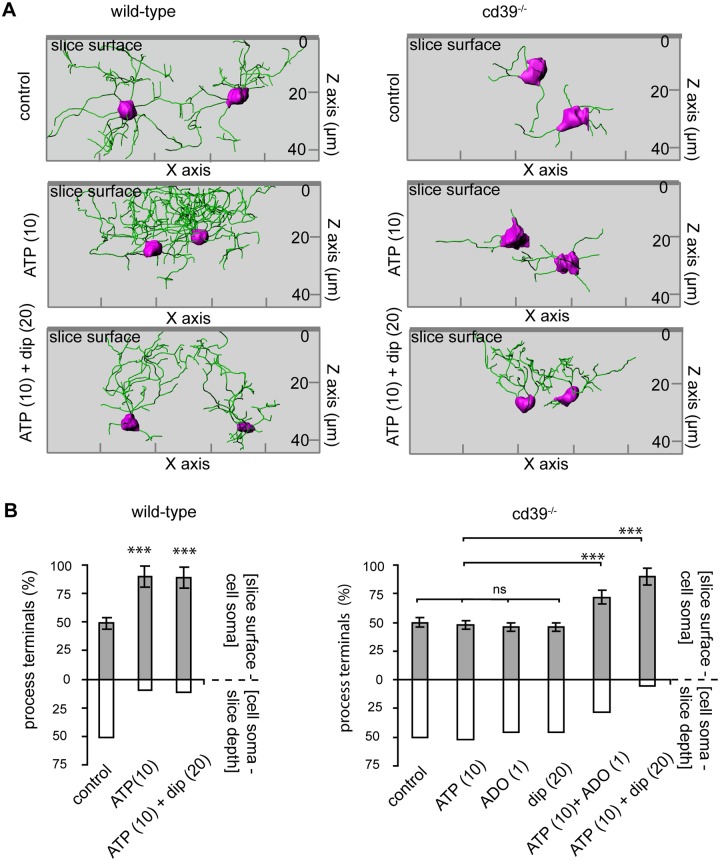
Directional movement of microglial processes towards the surface in acute brain slices requires ATP and adenosine.(A) Representative rendered images of 3-dimensional confocal fluorescence images of iba-1/Alexa fluo-488 labelled microglia in acute brain slices of wild-type (left) and cd39-/- (right) mice are shown. The green lines show the processes, and the cell soma is labeled in pink. In wild-type and cd39-/- mice, the microglial processes are randomly distributed around the cell soma in control conditions. In wild-type mice but not in cd39-/- mice, ATP (10 μM) induced re-orientation and elongation of microglial processes towards the slice surface (left two images). Dipyridamole (dip, 20 μM) restored the ability of cd39-/- microglia to re-orient the processes in an ATP gradient. On the Z axis, the coordinate of the slice surface is zero (0). (B) The bars show a distribution of the cumulative number of process terminal points between two compartments: above (grey) and below (white) the position of the microglia soma with respect to the slice surface. ns denotes p > 0.5, *** denotes p < 0.001.